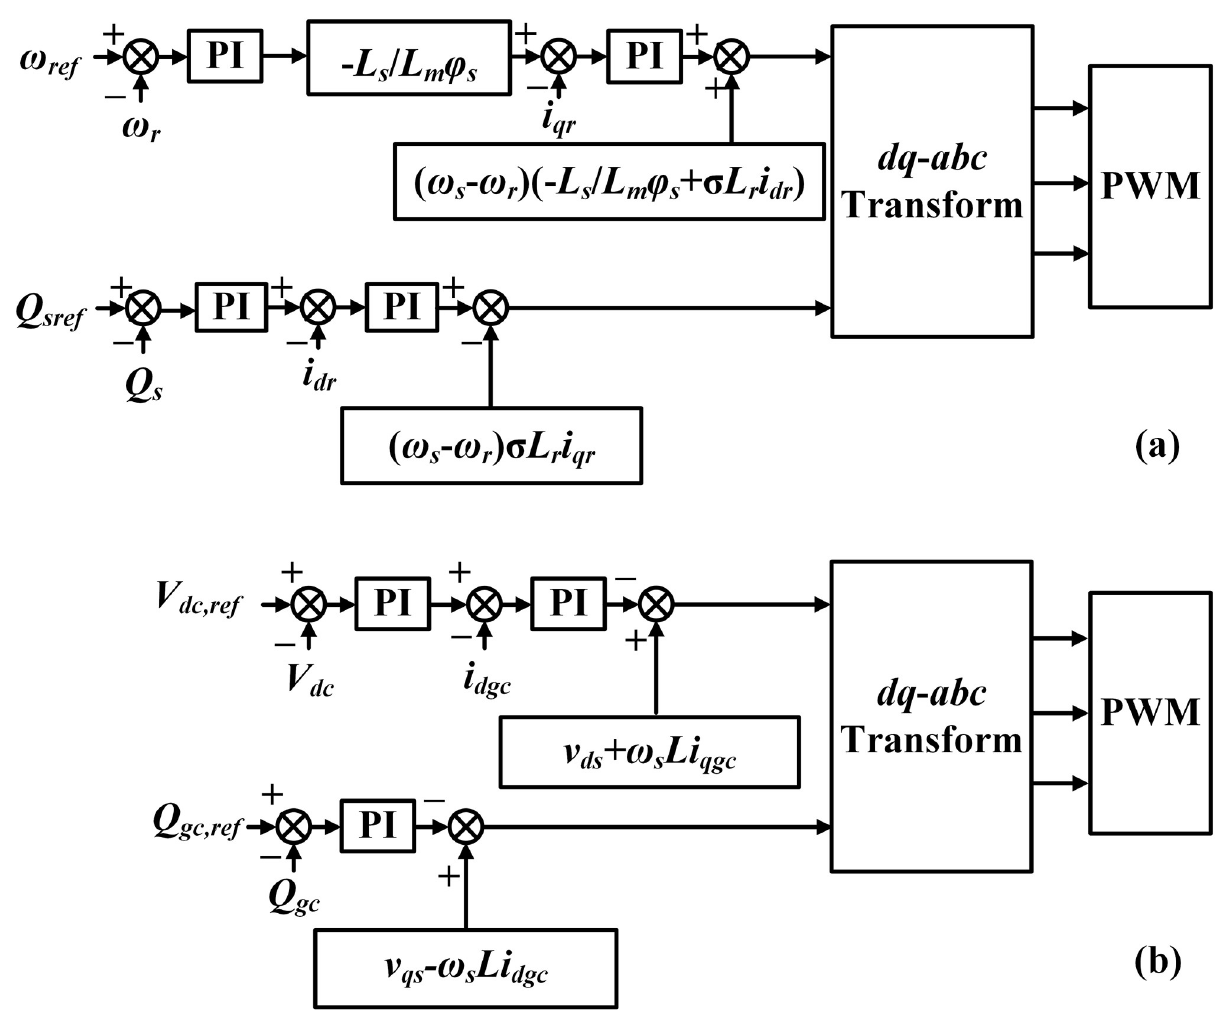
Fig 2. Control block diagram of the DFIG converters. (a) RSC, (b) GSC.